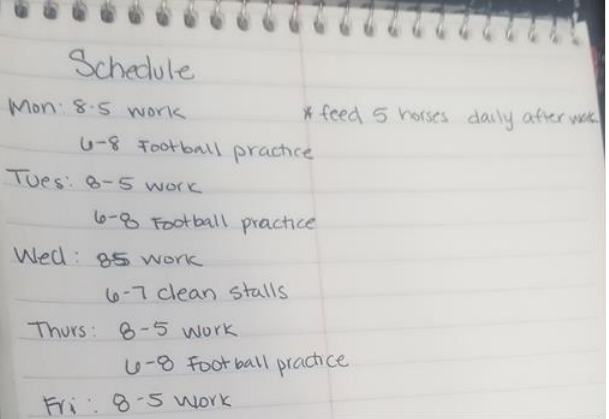
Figure 4. Family’s weekly schedule (photograph submitted by family).